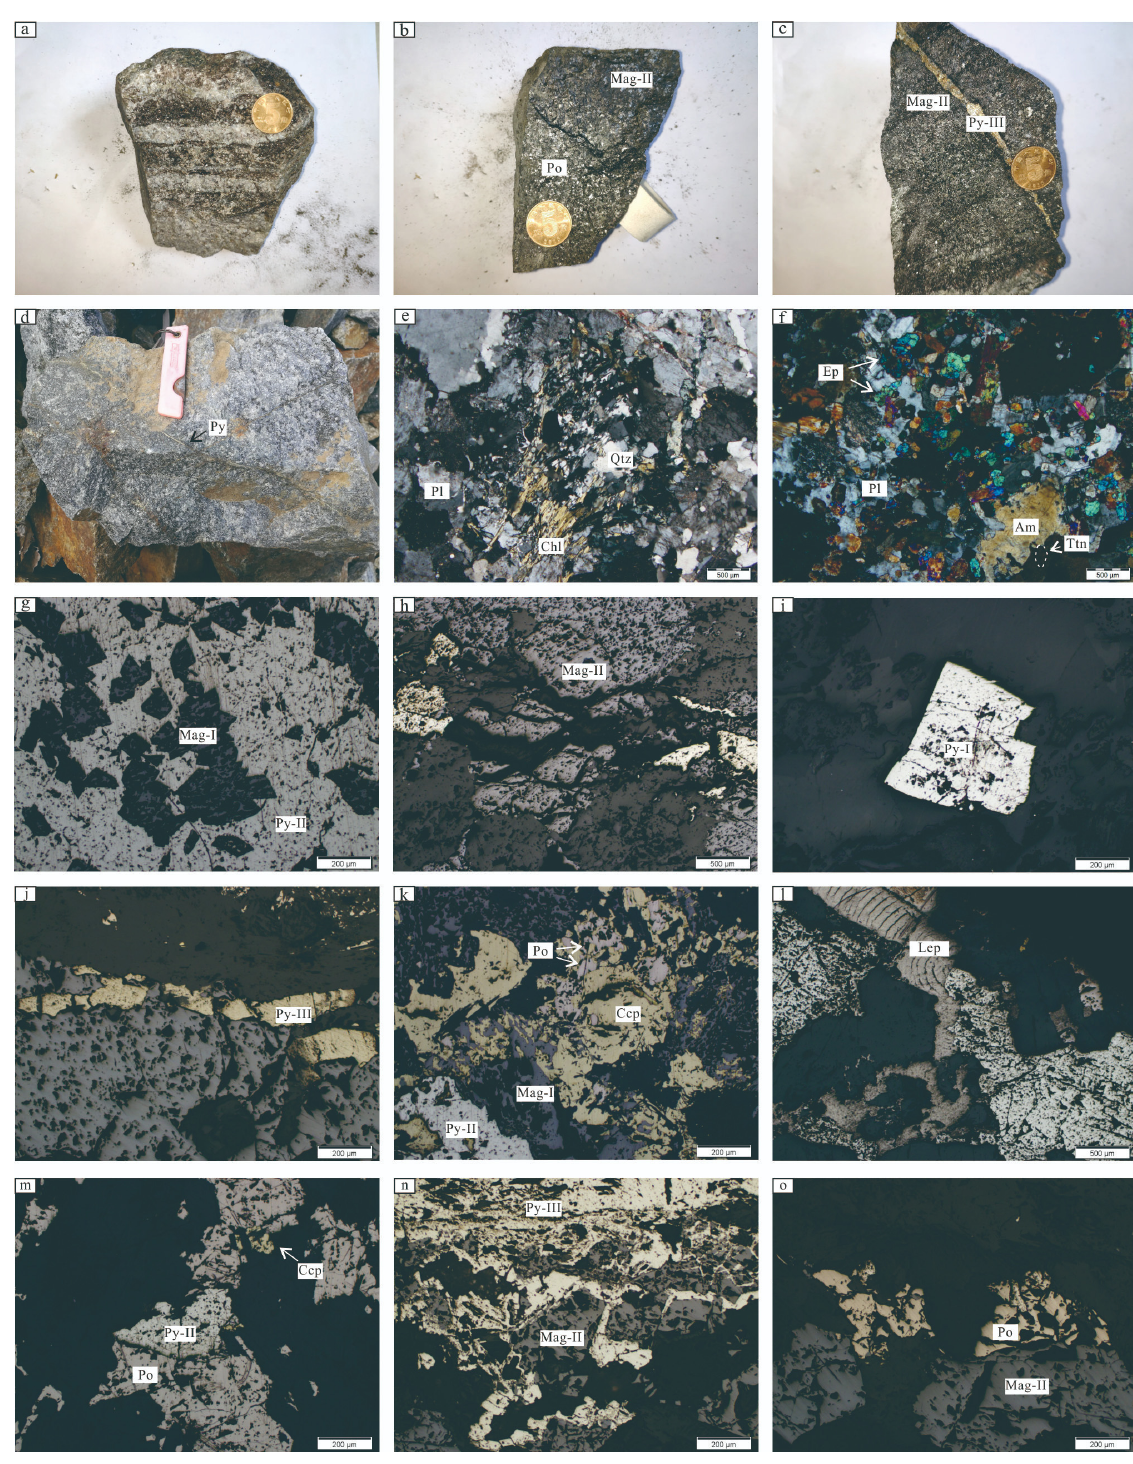
Figure 4. Photos/photomicrographs of migmatitic granite and amphibolite at the Weizigou deposit: ( a ) hand specimen of granitic gneiss; ( b ) hand specimen of ore-bearing meta-gabbro; ( c ) vein-like pyrite in meta-gabbro; ( d ) pyrite veinlets in granitic gneiss; ( e ) retrogressive metamorphism of biotite into chlorite in the granitic gneiss; ( f ) sericite and epidote alteration in the meta-gabbro; ( g ) euhedral magnetite (Mag-I); ( h ) disseminated magnetite (Mag-II); ( i ) euhedral pyrite (Py-I); ( j ) vein pyrite (Mag-III) is distributed along the fracture or edge of magnetite (Mag-II); ( k ) chalcopyrite, pyrite (Py-II) and pyrrhotite; ( l ) lepidocrocite; ( m ) hypidiomorphic pyrite (Py-II) and pyrrhotite; ( n ) disseminated magnetite (Mag-II) replaced by pyrite (Py-III); ( o ) disseminated magnetite (Mag-II) and pyrrhotite. Am—amphibole; Ccp—chalcopyrite; Chl—chlorite; Ep—epidote; Mag—magnetite; Pl—Plagioclase; Po—pyrrhotite; Py—pyrite; Qtz—Quartz; Ttn—titanite.